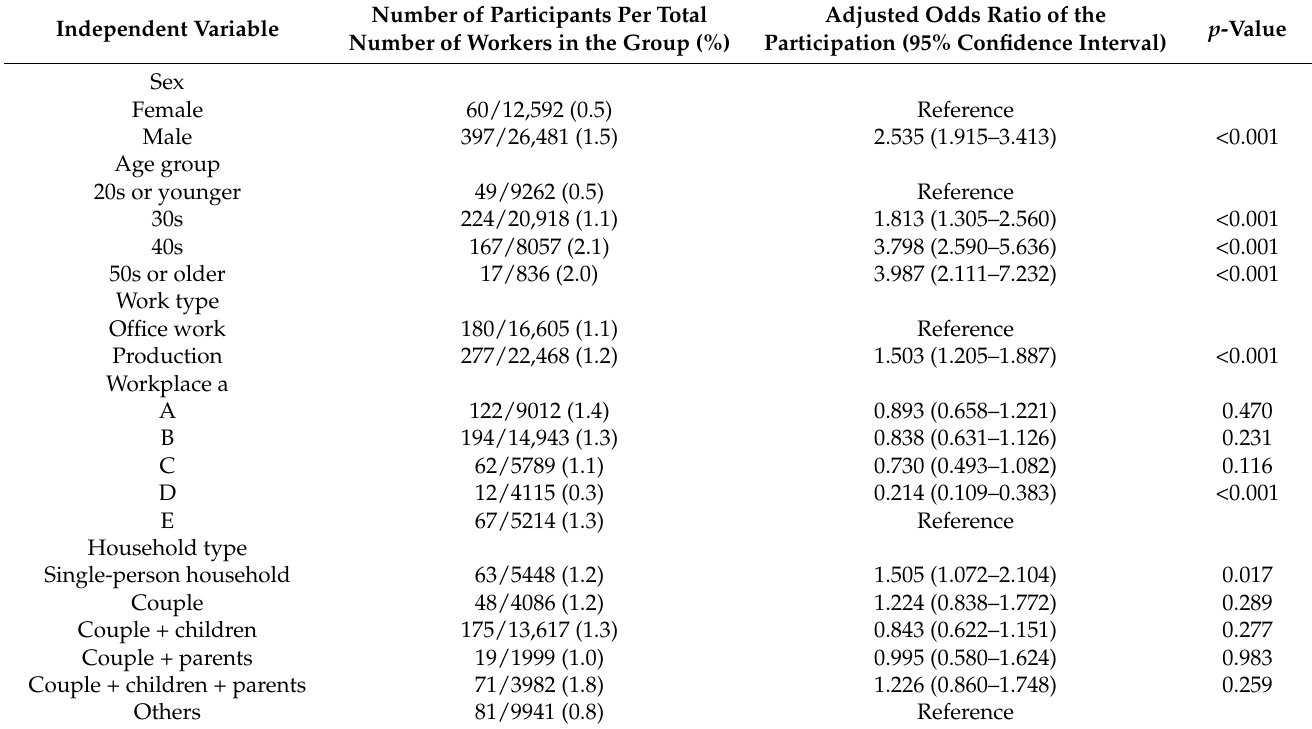
Table 4. Factors influencing participation in workplace health promotion programs by employees of the semiconduc- tor/liquid crystal display (LCD)